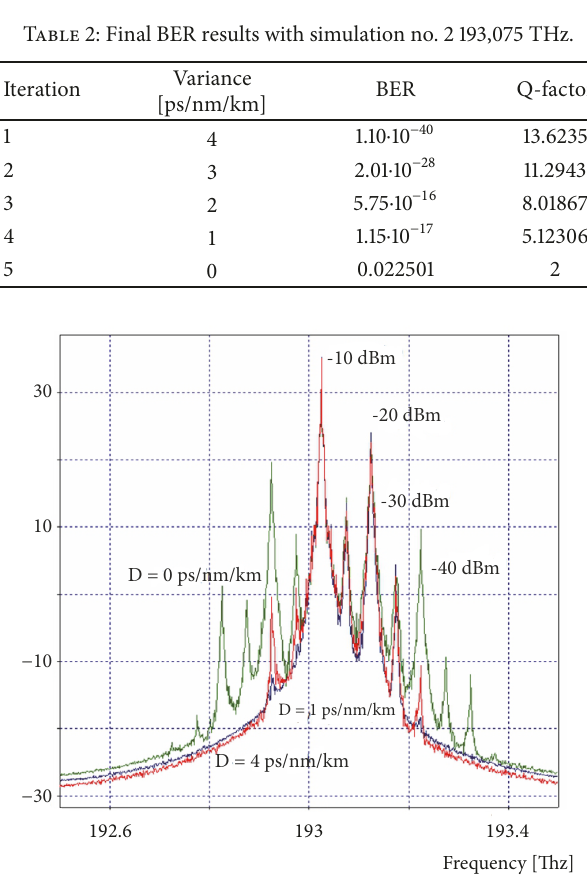
Figure 4: Final signal spectrum for simulation no.